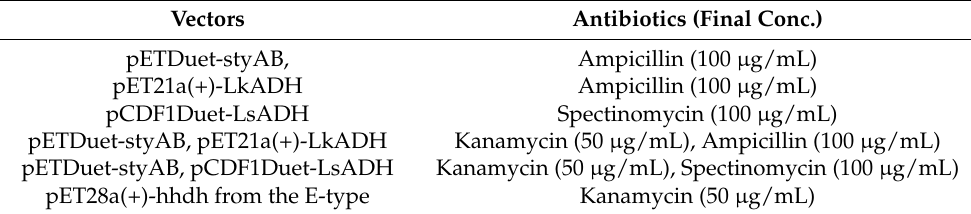
Table 4. List of vectors and corresponding antibiotics used in this work. Vectors Antibiotics (Final Conc.)